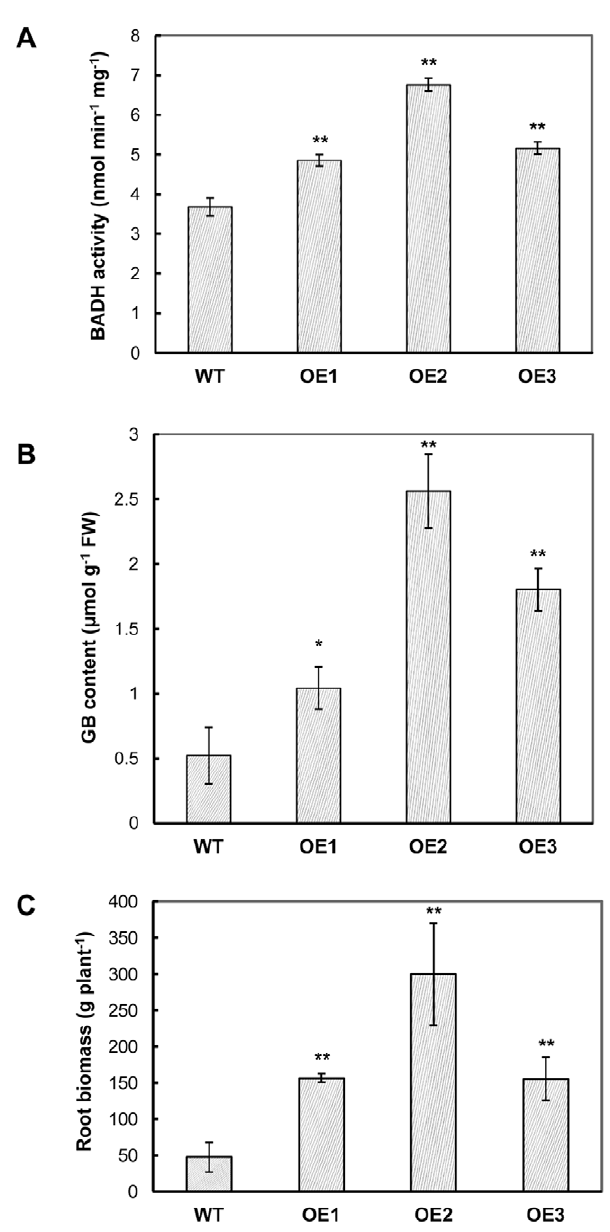
Figure 1. BADH accumulation and root biomass of wild-type and the SoBADH transgenic plants. A and B show the BADH activity and GB content in the leaves, respectively; C shows the root biomass. OE1–OE3, SoBADH overexpressing transgenic lines; WT, wild-type plant. Values represent the mean 6 SD (n=9). Asterisks indicate a significant difference from that of WT at * P , 0.05 or ** P , 0.01 by t -test.